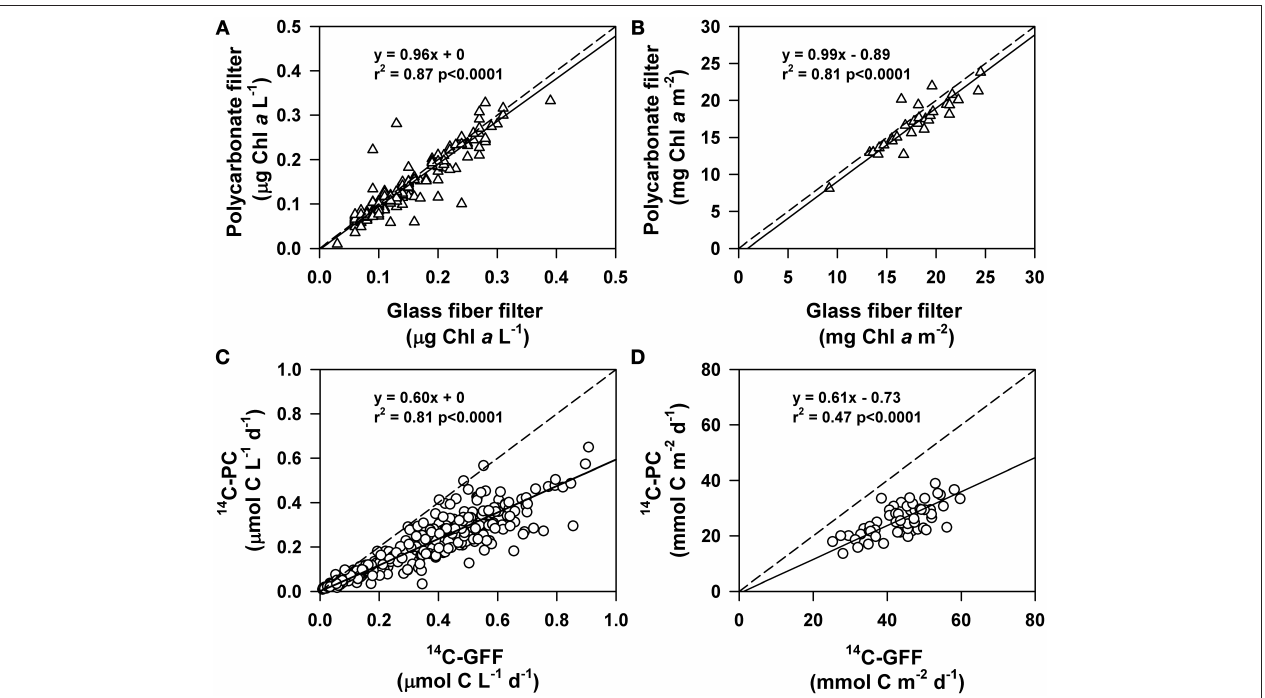
FIGURE 4 | Comparison of measurements of chlorophyll a and 14 C-primary production on either glass fiber or polycarbonate filters. Solid lines are Model II (geometric mean) linear regressions, while dashed lines depict the 1:1 ratio. Shown on each plot are the regression equation, the r 2 of the relationship, and the p -value for (A) volumetric measurements of chlorophyll a , (B) depth-integrated (0–125 m) chlorophyll a , (C) volumetric measurements of 14 C-primary production, and (D) depth-integrated (0–125 m) measurements of 14 C-primary production.